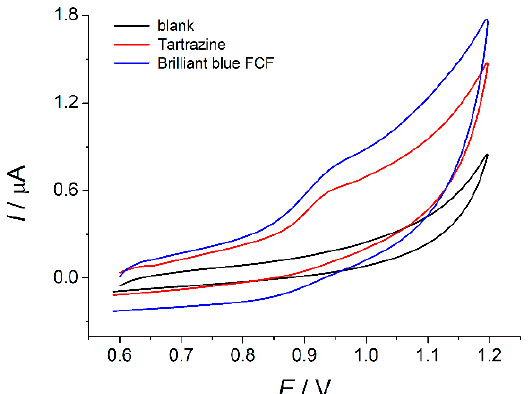
Figure 2. Cyclic voltammograms of 10 µ M tartrazine and brilliant blue FCF on the bare GCE in phosphate buffer pH 7.0 ( υ = 100 mV s − 1 ).